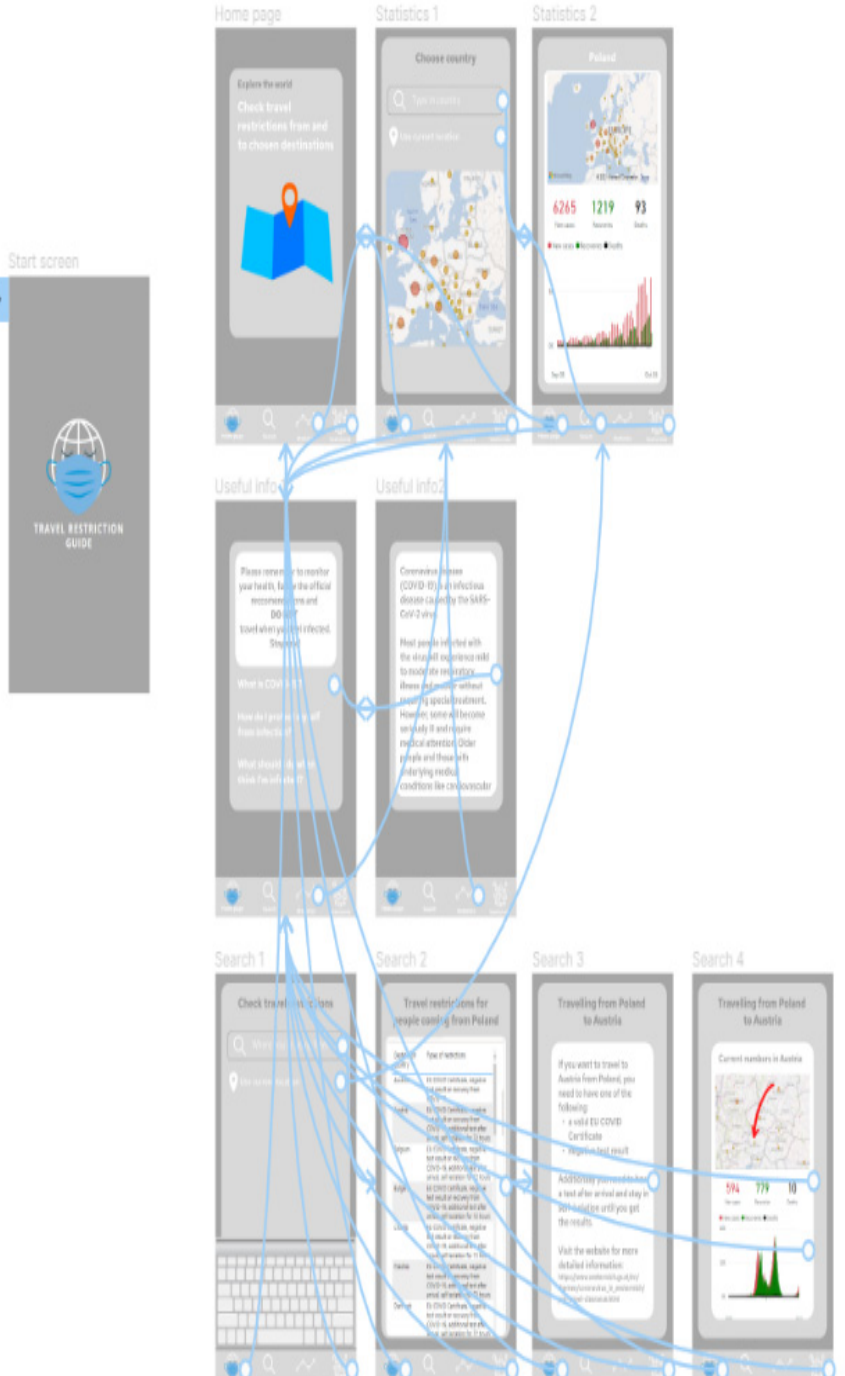
Figure 12. Project with transition arrows showing how the user can move between screens using particular buttons in the